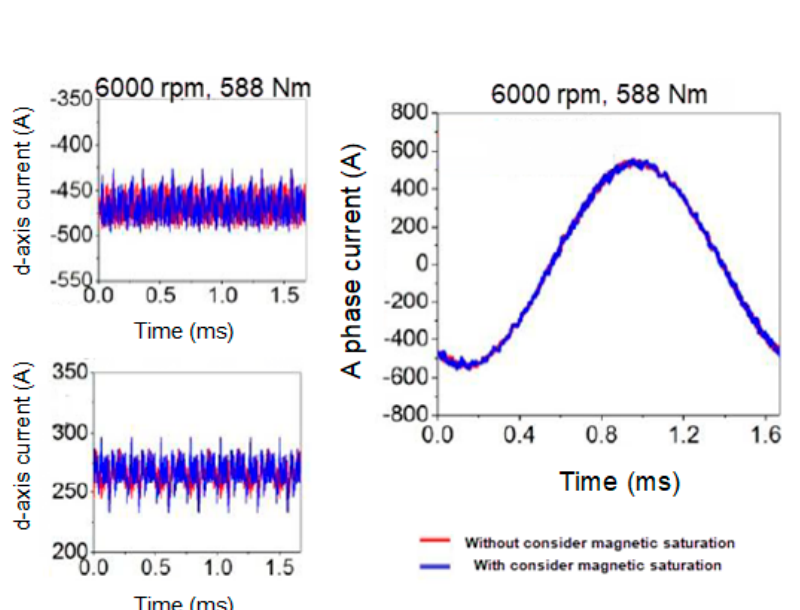
Figure 2. Phase current and dq-axis current under different working points of the motor.